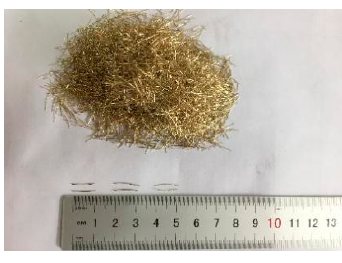
Figure 1. Steel Figure 1 . Steel fiber. Table 5. Physical properties of steel fiber.